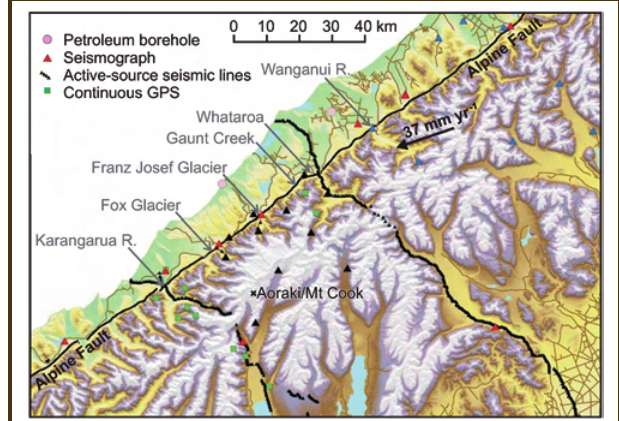
Figure 3. Map of the central section of the Alpine Fault showing existing infrastructure, the onshore portions of the South Island Geophysical Transect (SIGHT) active-source seismic lines, background seismicity, and the locations of possible drill sites.